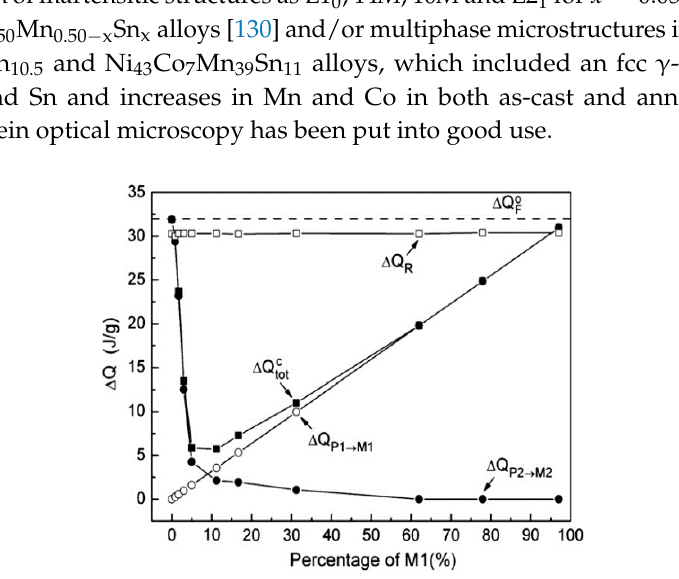
Figure 15. The absolute value of latent heat of P1–M1 and P2–M2, total latent heat and the reverse latent heat after interrupted cooling as a function of M1 percentage [50], with copyright permission from © Nature Publishing Group .